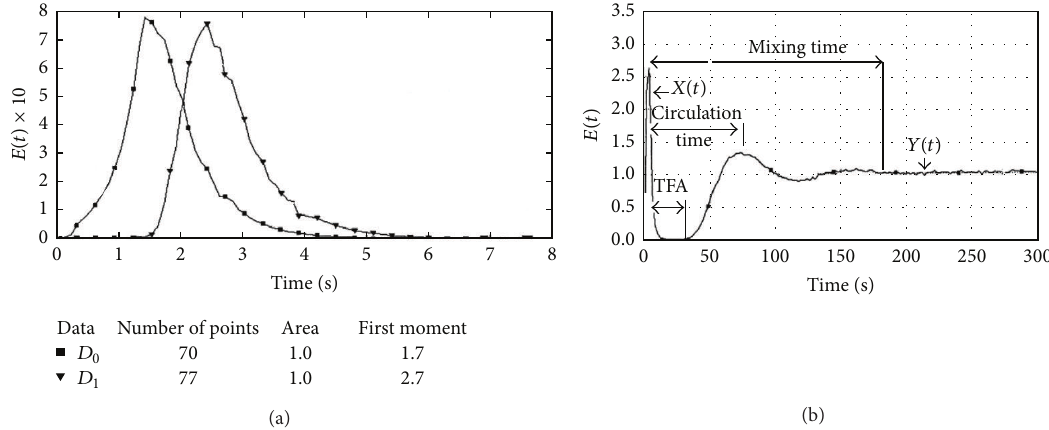
Figure 8: (a) Flow rate measurement; (b) time of first appearance, circulation, and homogenisation or mixing time by Pant et al. 2001 [5].